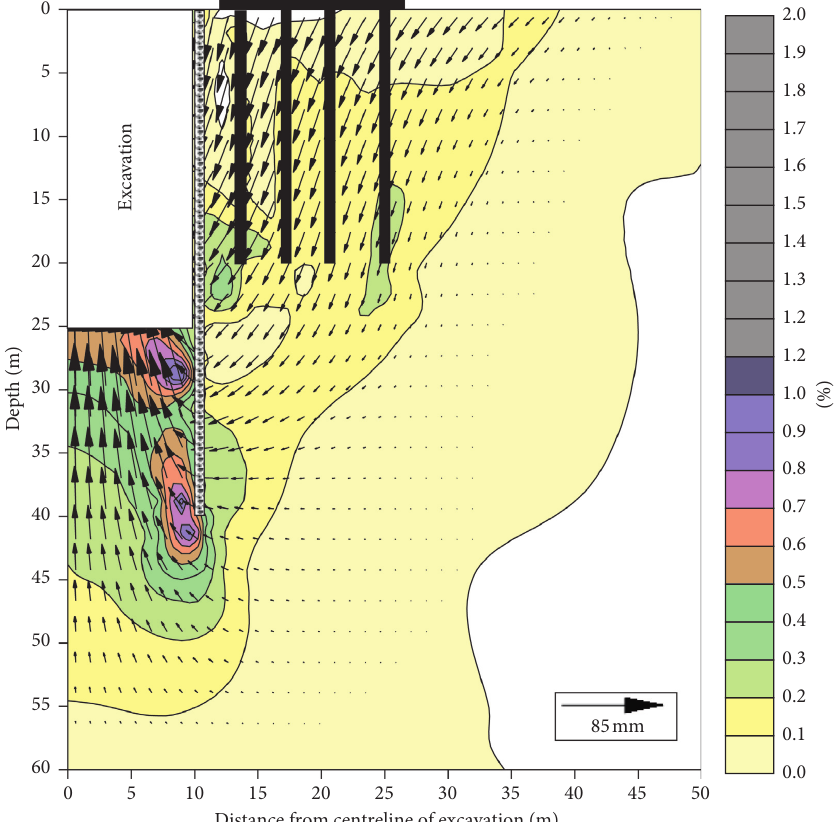
Figure 9: Computed soil displacement vectors and incremental deviatoric strain contours due to